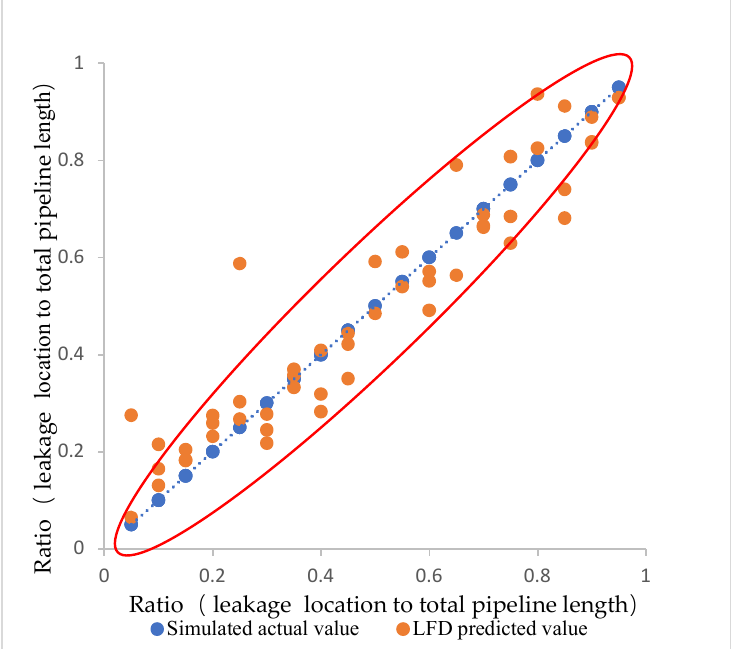
Ratio （ leakage location to total pipeline length ） Simulated actual value LFD predicted Figure 10. Distribution of simulated actual leakage locations and LFD-predicted locations for pipe13.